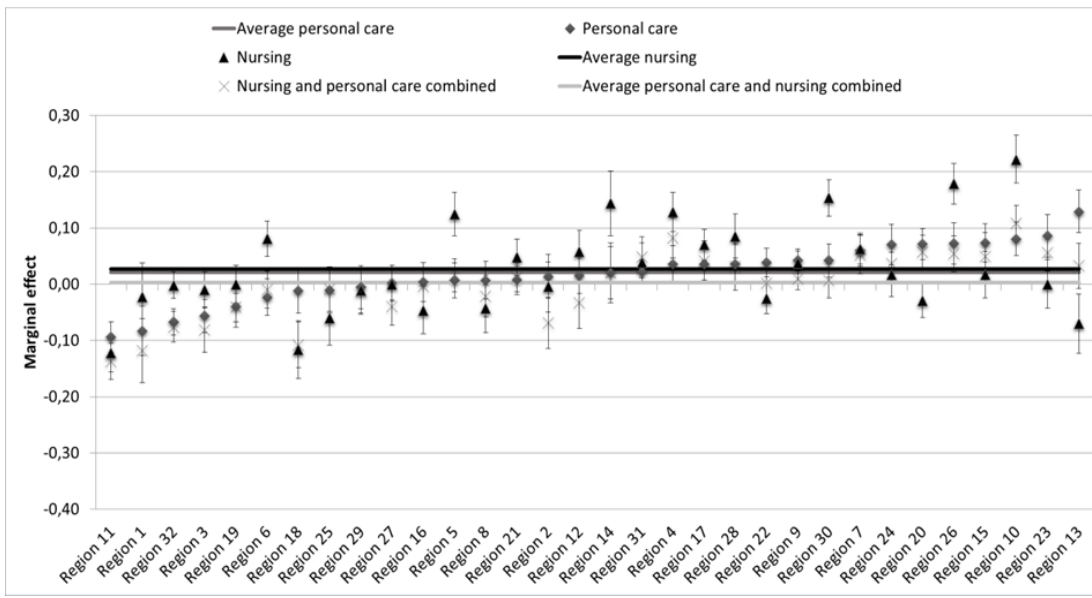
Figure 3.1: Variation in the personal care entitlements granted regarding nursing and personal care and nursing combined 65 and older